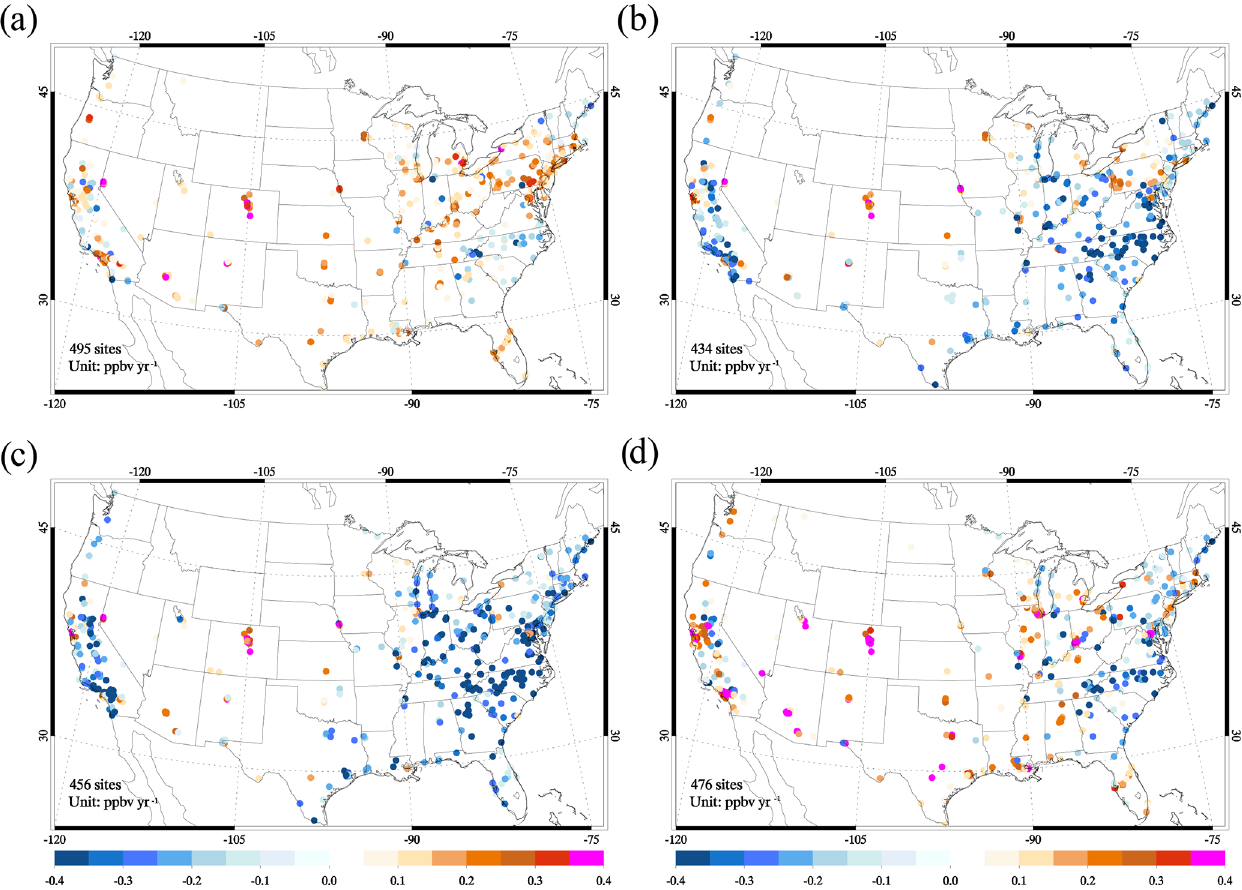
Figure 7. Trend in ozone observations at selected EPA AQS sites during 1990–2015 (in parts per billion by volume per year) at (a) 08:00LT, (b) 12:00LT, (c) 16:00LT and (d) 20:00LT. We only show the sites with a statistically significant linear trend in the